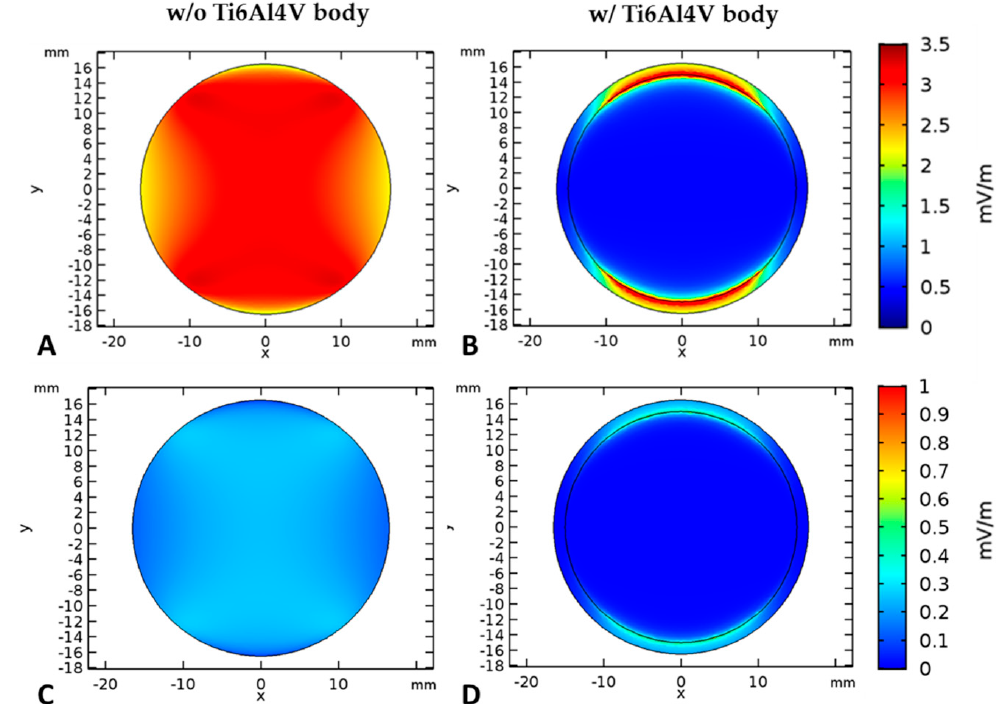
Figure 2. Electric field distribution (( A , B ): input voltage: 1 V RMS ; ( C , D ): input voltage: 100 mV RMS ) at 1 mm height above the bottom of the chamber (i.e., at cell location) without the Ti6Al4V body ( A , C ) and with Ti6Al4V body ( B , D ).